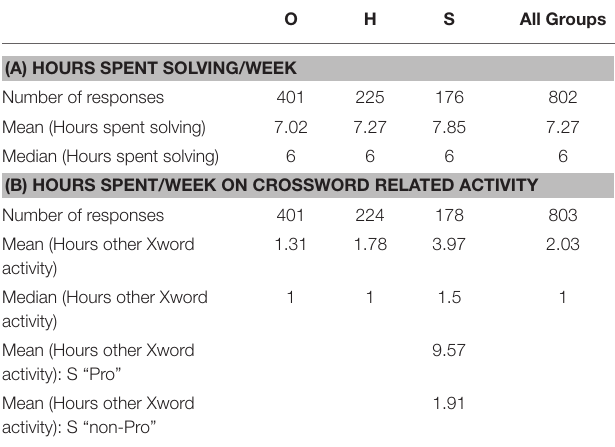
TABLE 3 | Key education data by expertise groups (with additional data for O/E split). O